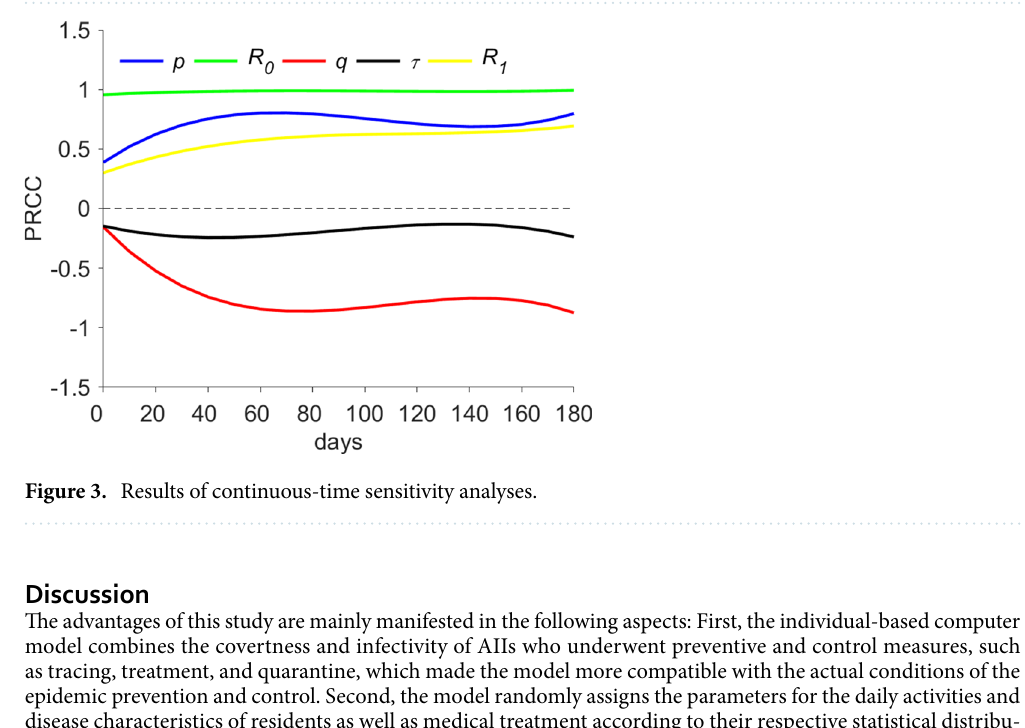
Figure 2. Considering p = 0.2, q = 0.5, an initial number of 1,000 AIIs, and in the presence of prevention and control measures, the transmission characteristics of the epidemic for different values of R 0 . ( a ) Temporal distribution of the number of new AIIs. ( b ) Temporal distribution of the number of new patients, ( c ) Temporal distribution of the cumulative number of new AIIs, ( d ) Temporal distribution of the cumulative number of new patients, and ( e ) Temporal distribution of the number of undetected AIIs. ( f ) Temporal distribution of the number of undetected patients. ( g ) Temporal distribution of the number of quarantined households. ( h ) Temporal distribution of the number of quarantined residents.